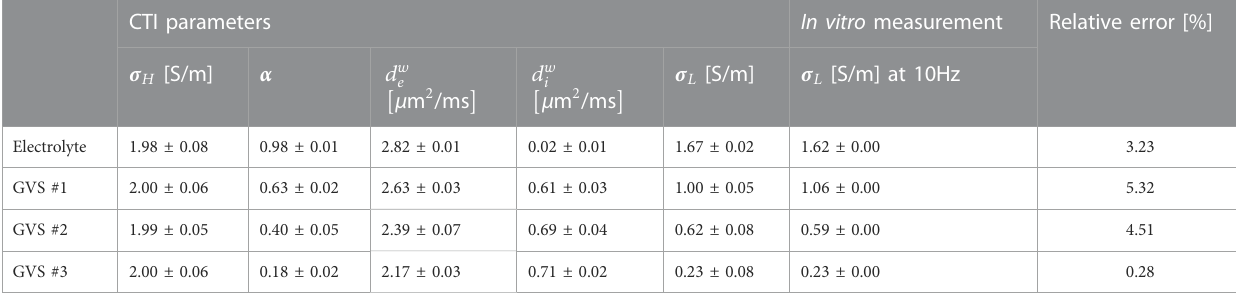
TABLE 1Summary ofCTI parameters withdifferentGVSdensities.The relative errorof conductivity wascalculated betweenthe low-frequencyconductivity of CTI and the in vitro measurement at 10 Hz. CTI